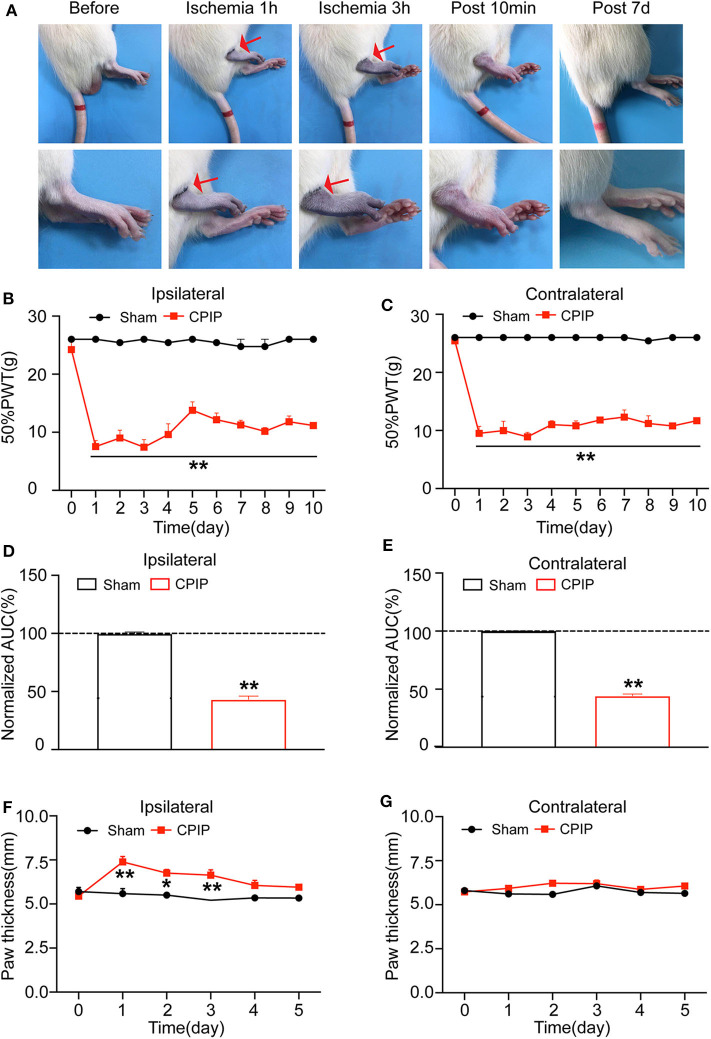
The rat chronic post-ischemic pain model (CPIP) exhibited long-lasting bilateral mechanical allodynia. (A) Representative photographs of rat hind paw taken during CPIP model establishment, 10 min and 7 day after model establishment. The red arrow indicates the paw with the O-ring (ipsilateral side). (B) 50% paw withdraw threshold (PWT) of ipsilateral hind paw. (C) 50% PWT of contralateral hind paw. (D) Summary of the normalized area under the curve (AUC) as in (B). (E) Summary of the normalized AUC as in (C). (F) Thickness evaluation of the ipsilateral hind paw. (G) Thickness evaluation of the contralateral hind paw. n = 6 rats/group. **p < 0.01 vs. Sham group. Student's t-test or two-way ANOVA followed by Tukey post-hoc test was used for statistical analysis. *p < 0.05.